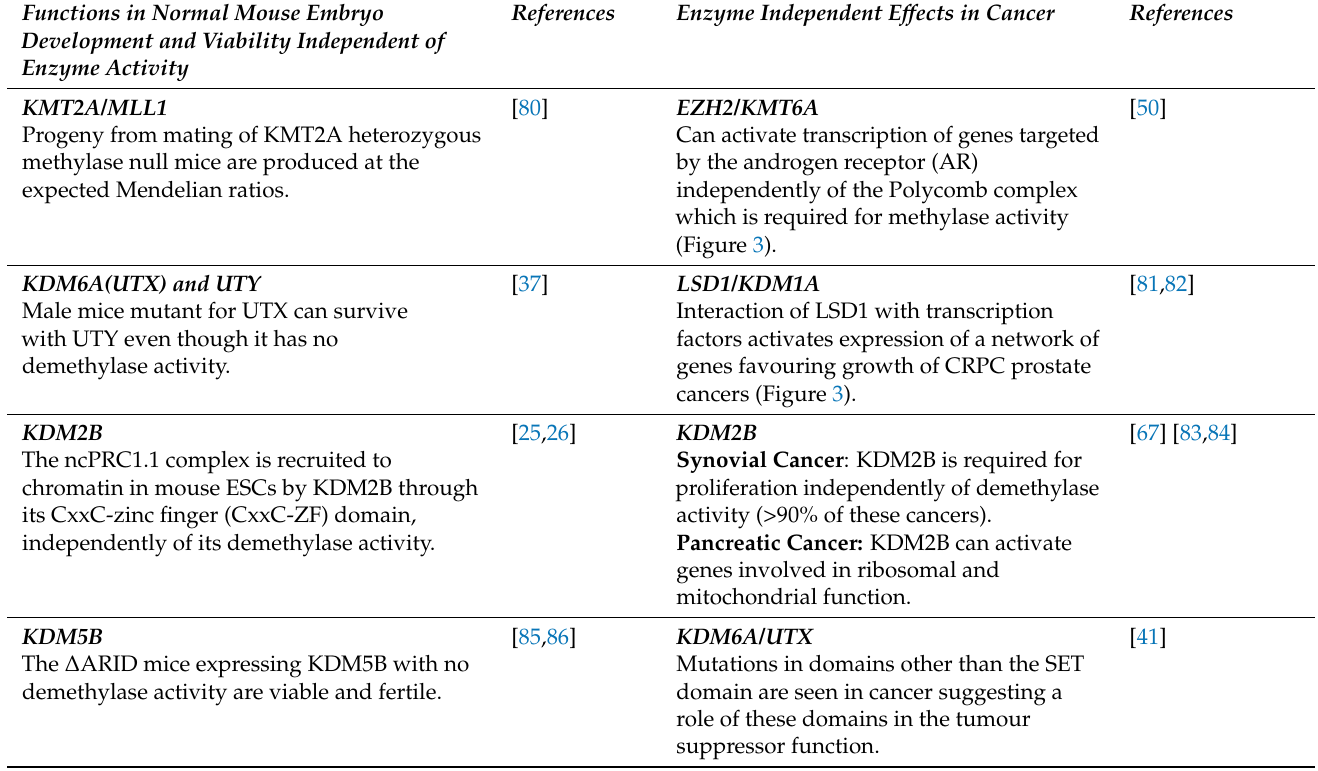
Table 2. Methylases and demethylases: functions independent of the enzyme activity of the two classes of